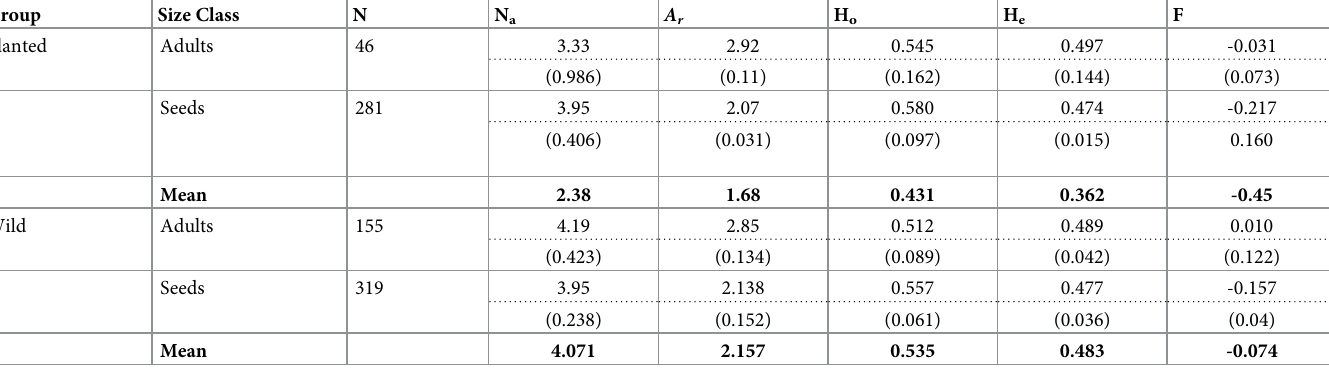
Table 1. Genetic diversity parameters of wild and planted stands of Spondias purpurea in northwestern Costa Rica, using seven microsatellite loci developed by Cristobal-Perez et al. (2019). Group